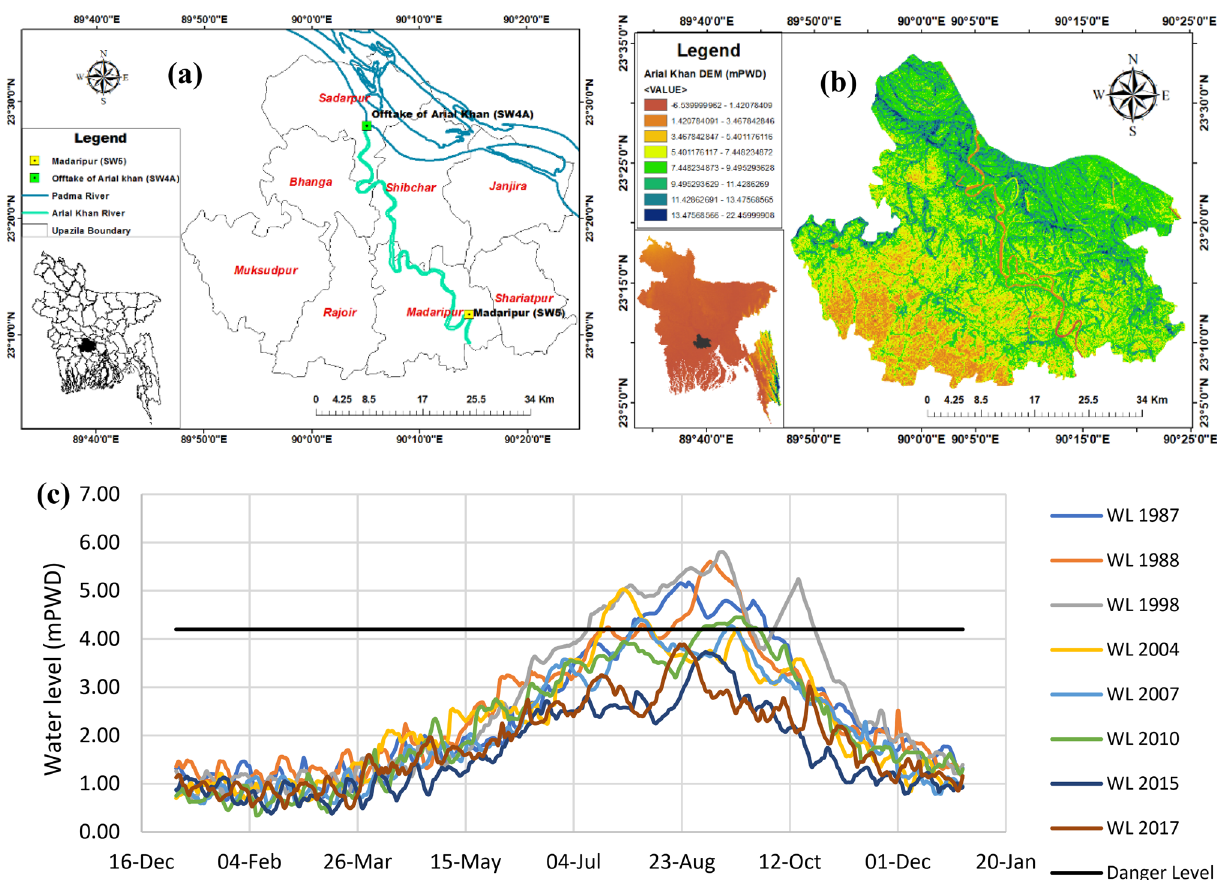
Fig. 1 Study area: Arial Khan River and its floodplain a administrative boundary b DEM c Comparison of flood hydrographs at Madaripur sta- tion (SW 5) of Arial Khan